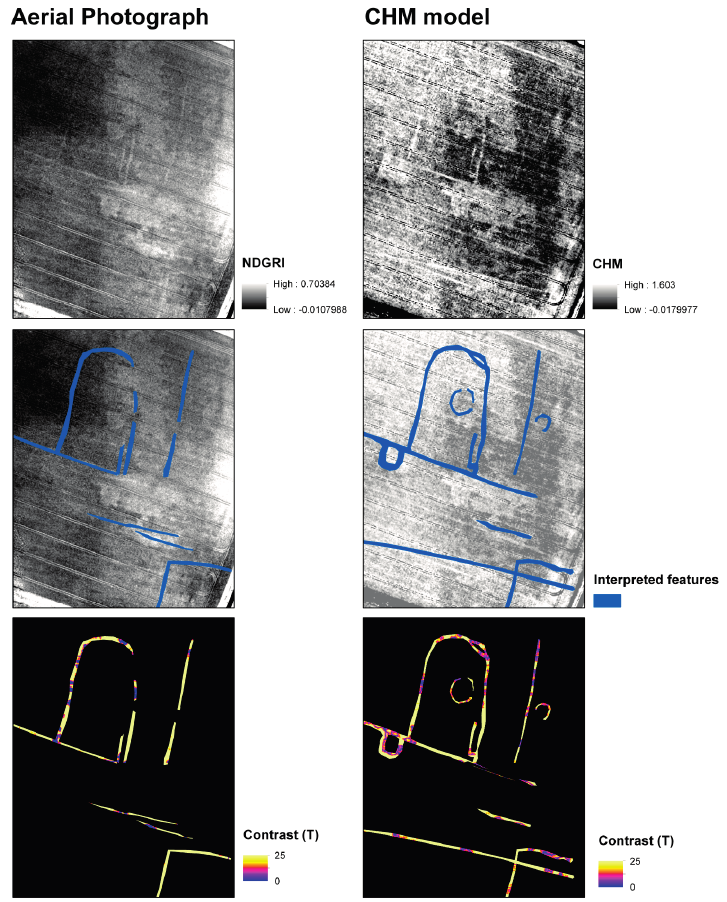
Figure 9. Comparison of the CHM method to NDGRI ortho-imagery for detecting previously unrecorded archaeological potential. This demonstrates that, while both methods can detect vegetation marks of archaeological potential, the CHM provides better definition of more features than the aerial